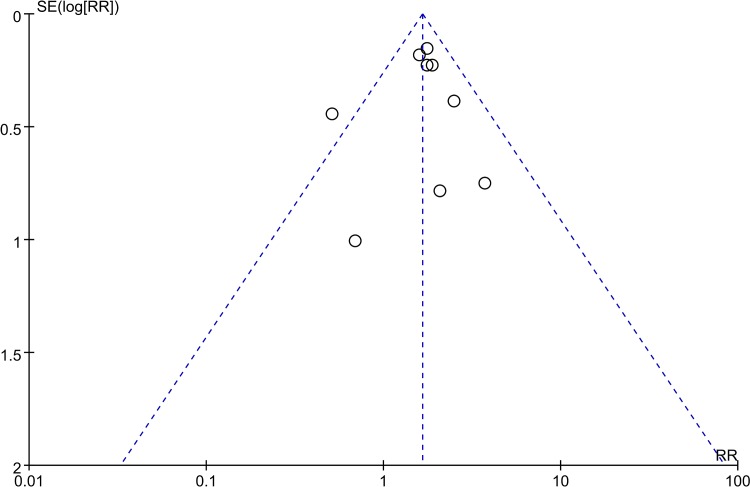
Funnel plots to test the potential publication bias of included studies reporting relevant data on the association of SCH without intervention and miscarriage.